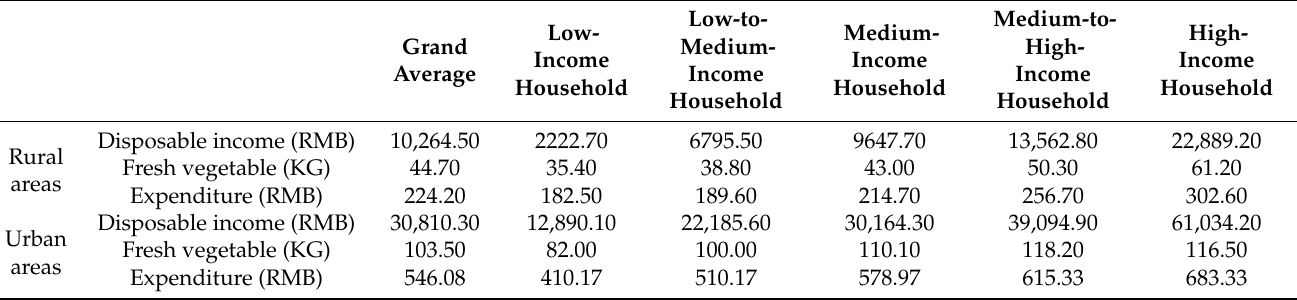
Table 1. Disposable income and vegetable consumption of different income brackets in